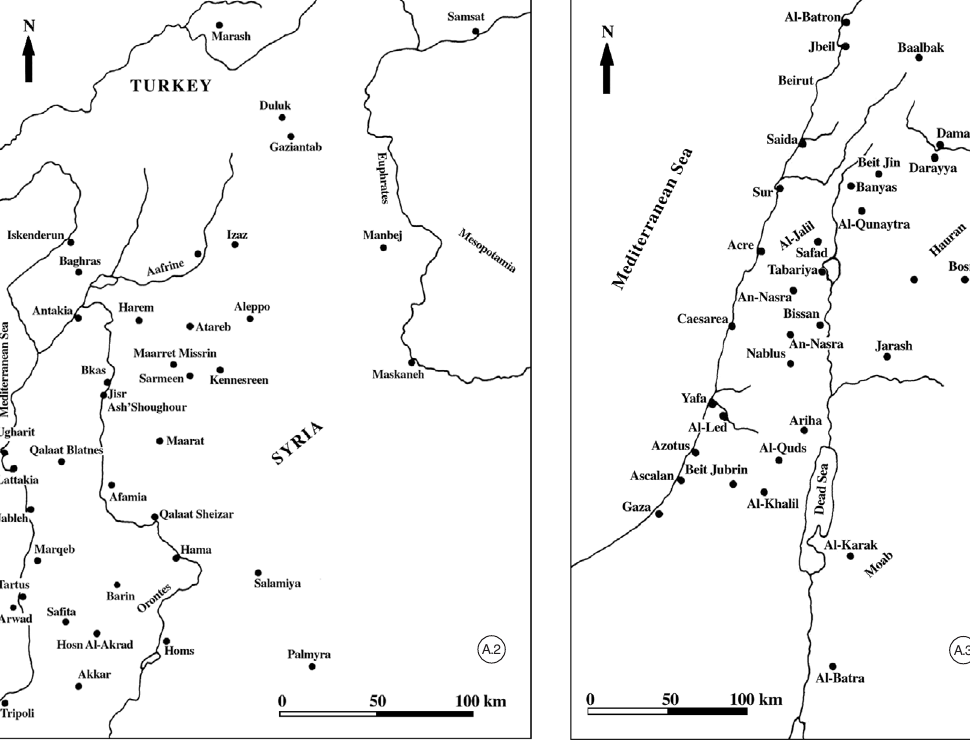
Fig. A.2. Localities affected by the historical earthquakes in Western and Northern Syria. Fig. A.3. Localities affected by the historical earthquakes in and around